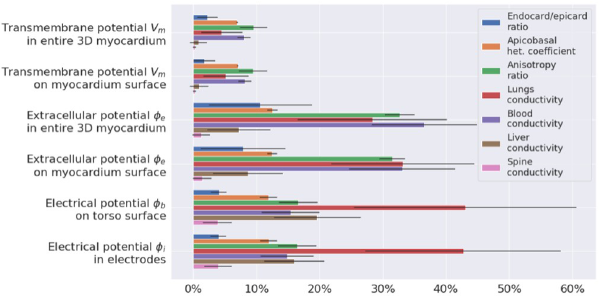
Fig 5. Integrative effect of parameter variation in the physiological range on the model output signals (see annotation in the left column). Different colors indicate individual parameters under variation (see legend). The effect was assessed using RED metrics with respect to output from the reference models. Bars show mean values across ten patient models, and error whiskers show standard deviations.